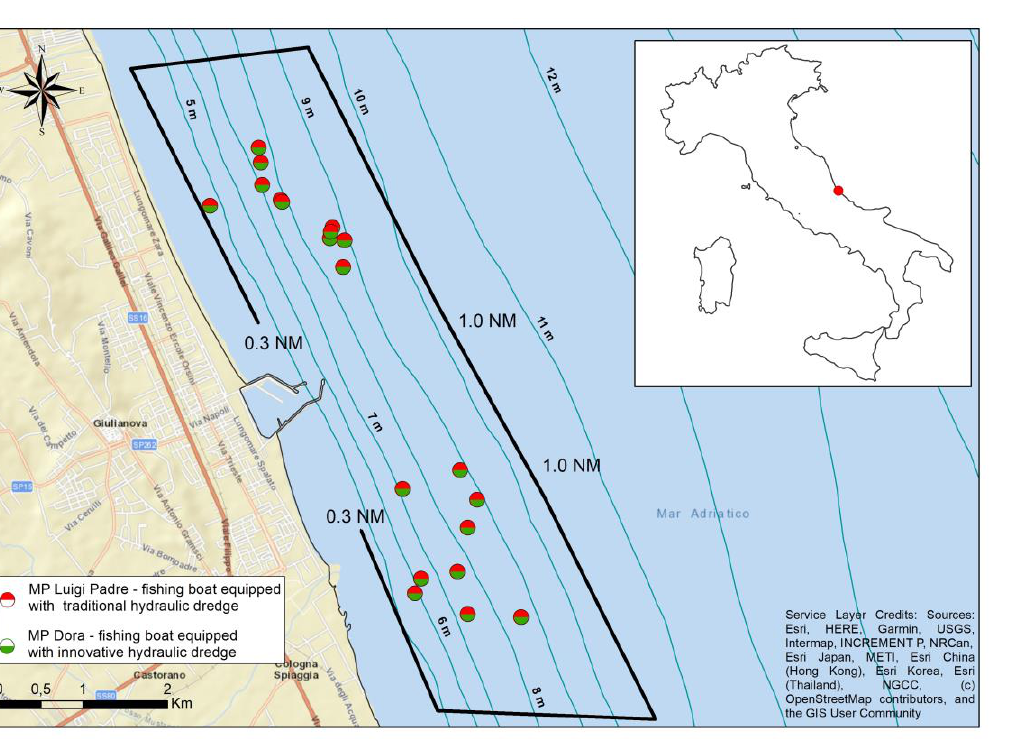
Figure 1. Geographical view of the Adriatic Sea in the Abruzzi coast with details of the sampling area for Chamelea gallina , sampling stations and bathymetry. Red and green half dots represent the sampling stations for MP Luigi Padre (traditional hydraulic dredge — half red) and MP Dora (innovative hydraulic dredge — half green).